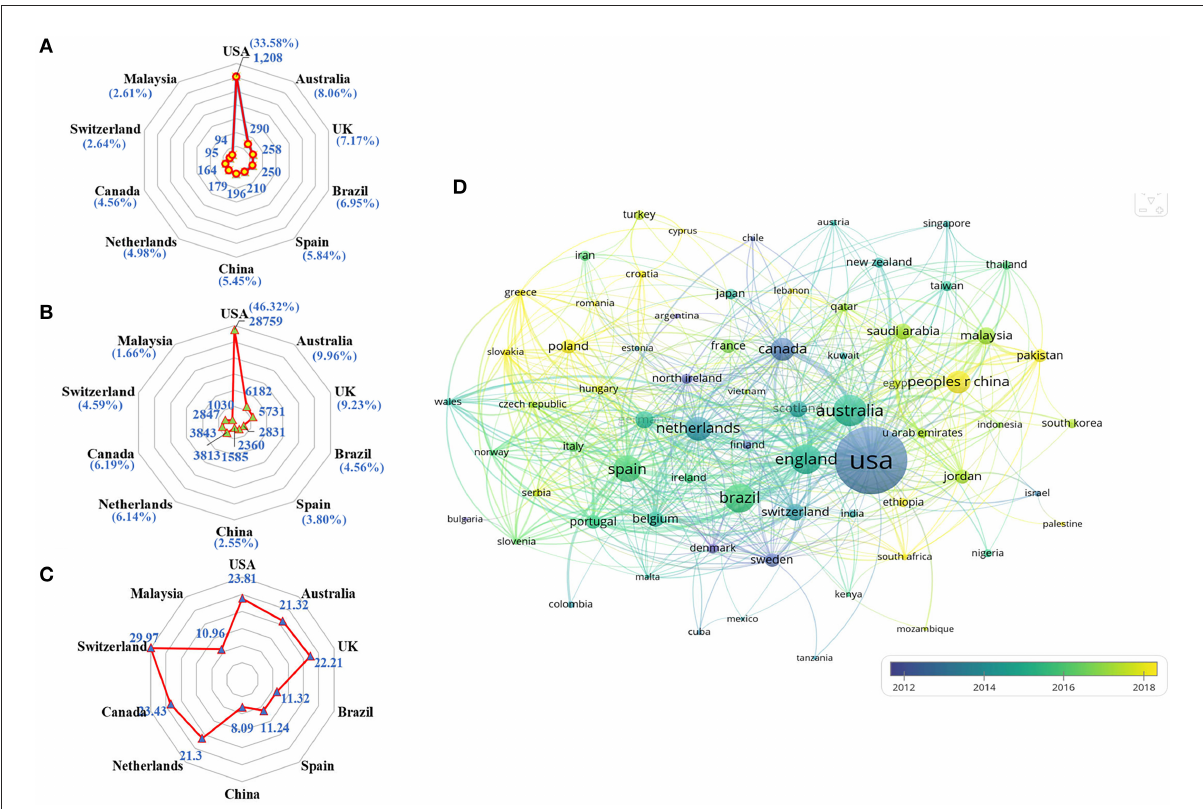
FIGURE3 Co-authorship analysis of countries/regions. (A) Radar map of Np in the top 10 countries. (B) Radar map of Nc in the top 10 countries. (C) Radar map of average citations per paper in the top 10 countries. (D) Overlay map of countries/regions with more than 5